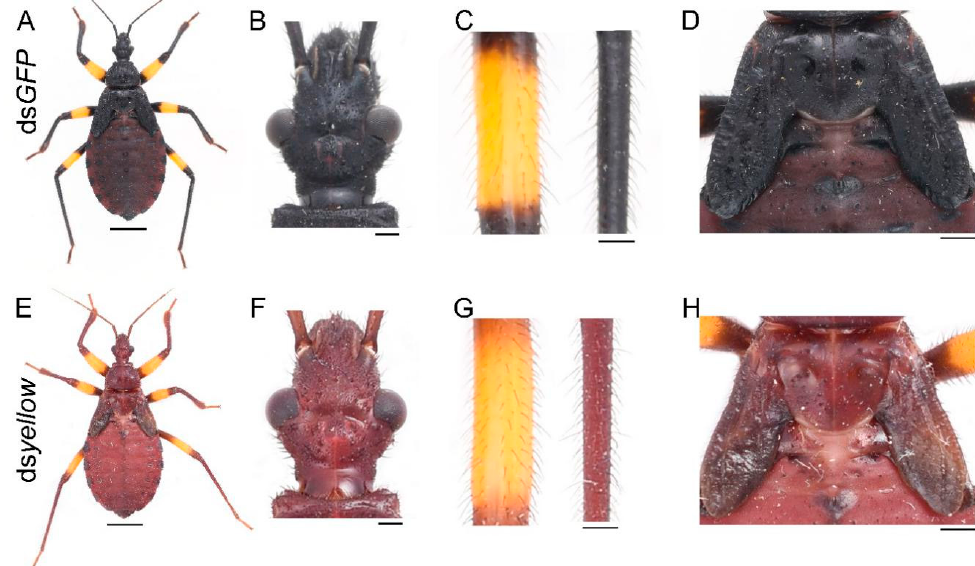
Figure 3. Functions of yellow in P. biguttatus nymphs. Nymphs treated with ds GFP showed normal pigmentation patterns ( A ), well-developed cuticles ( B , D ) and bristles ( C ). Nymphs injected with ds yellow showed a brown phenotype ( E ), with intact cuticles ( F , H ) and bristles ( G ). Scale bars, 5 mm ( A , E ), 500 μ m ( B , F ), 250 μ m ( C , G ), 1.25 mm ( D , H ).